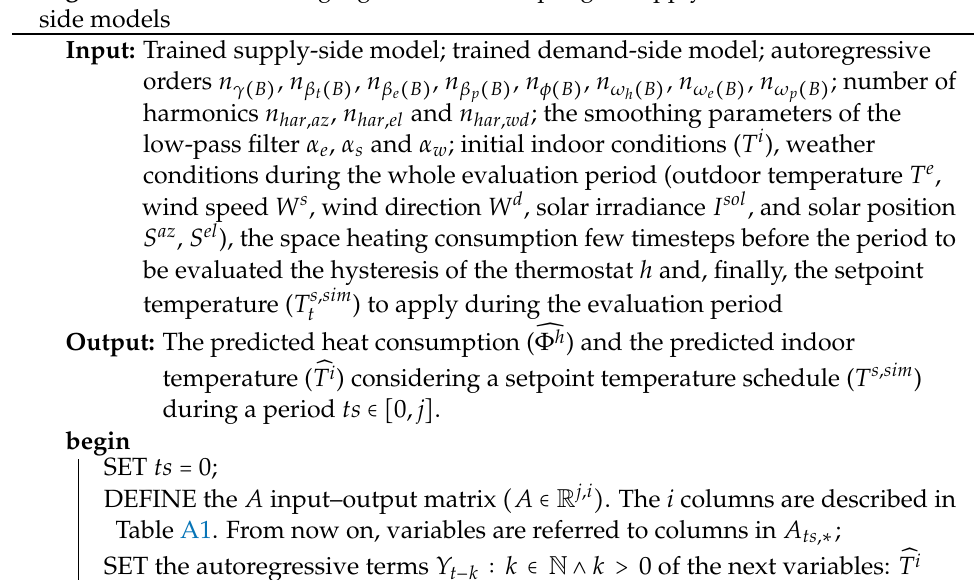
Algorithm A1: Forecasting algorithm and coupling of supply-side and